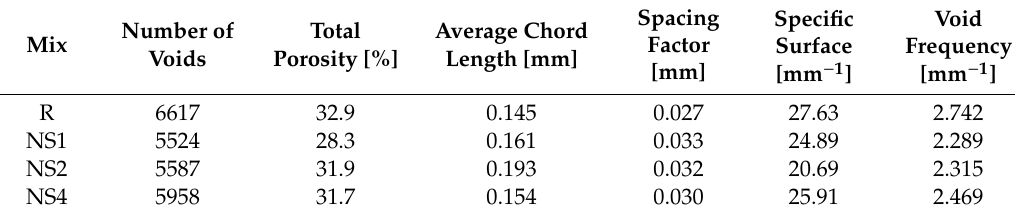
Table 4. Characteristics of air-voids in specimens.